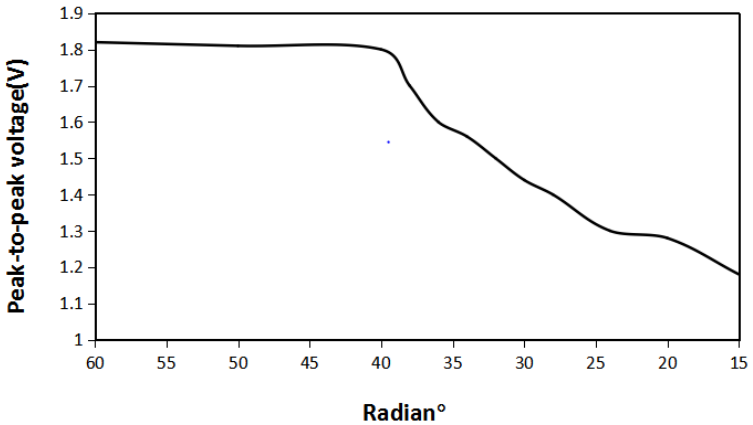
Figure 8. The maximum energy harvesting voltage of the Halbach array under different iron sheet radians.